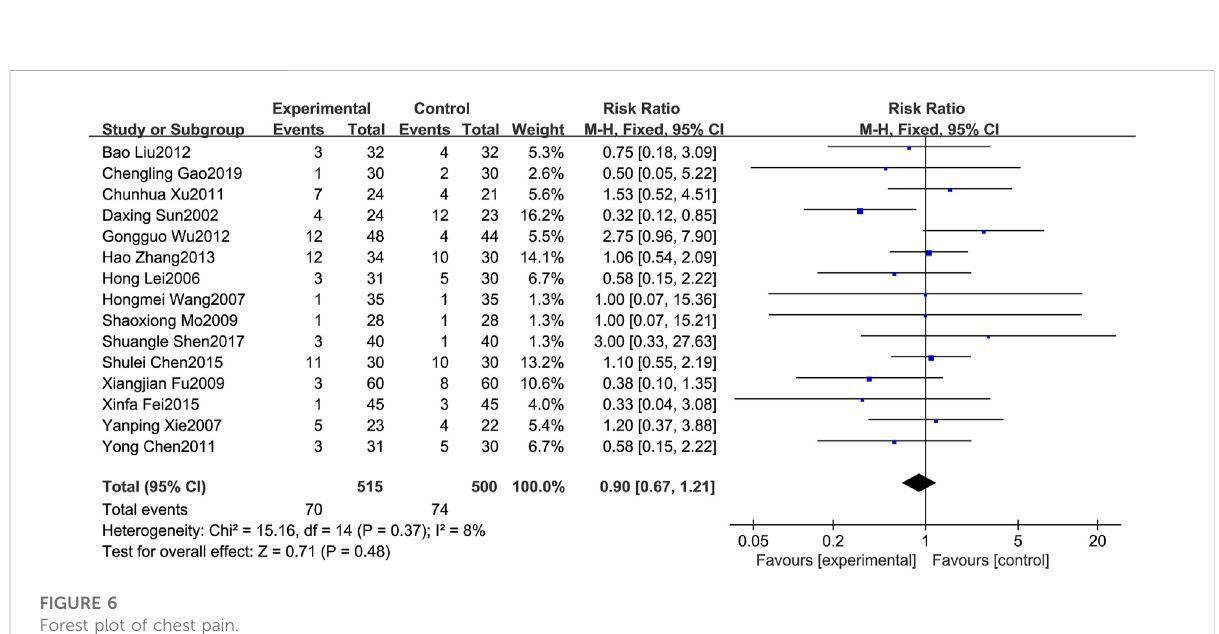
FIGURE 6 Forest plot of chest